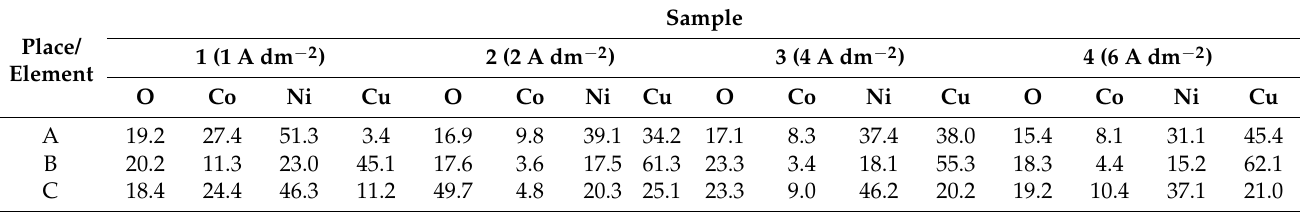
Table 4. Quantitative EDX analysis of element content in the area tribo track on Ni-Co coatings in wt. % after tribological test at the temperature of 400 °C at the listed current density.